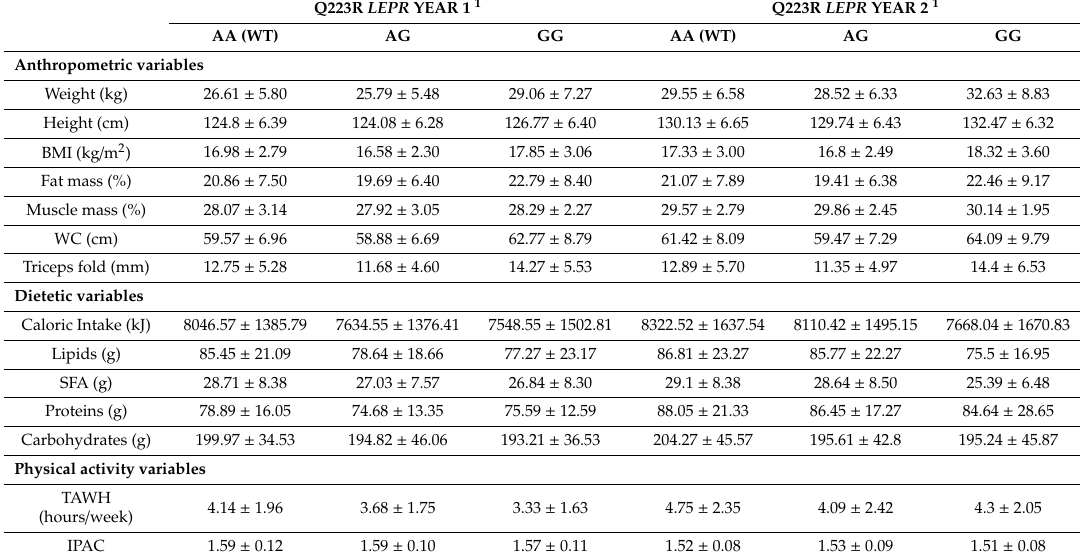
Table 2. Anthropometric, dietary, and physical activity characteristics of the study population according to Q223R genotypes in year 1 and